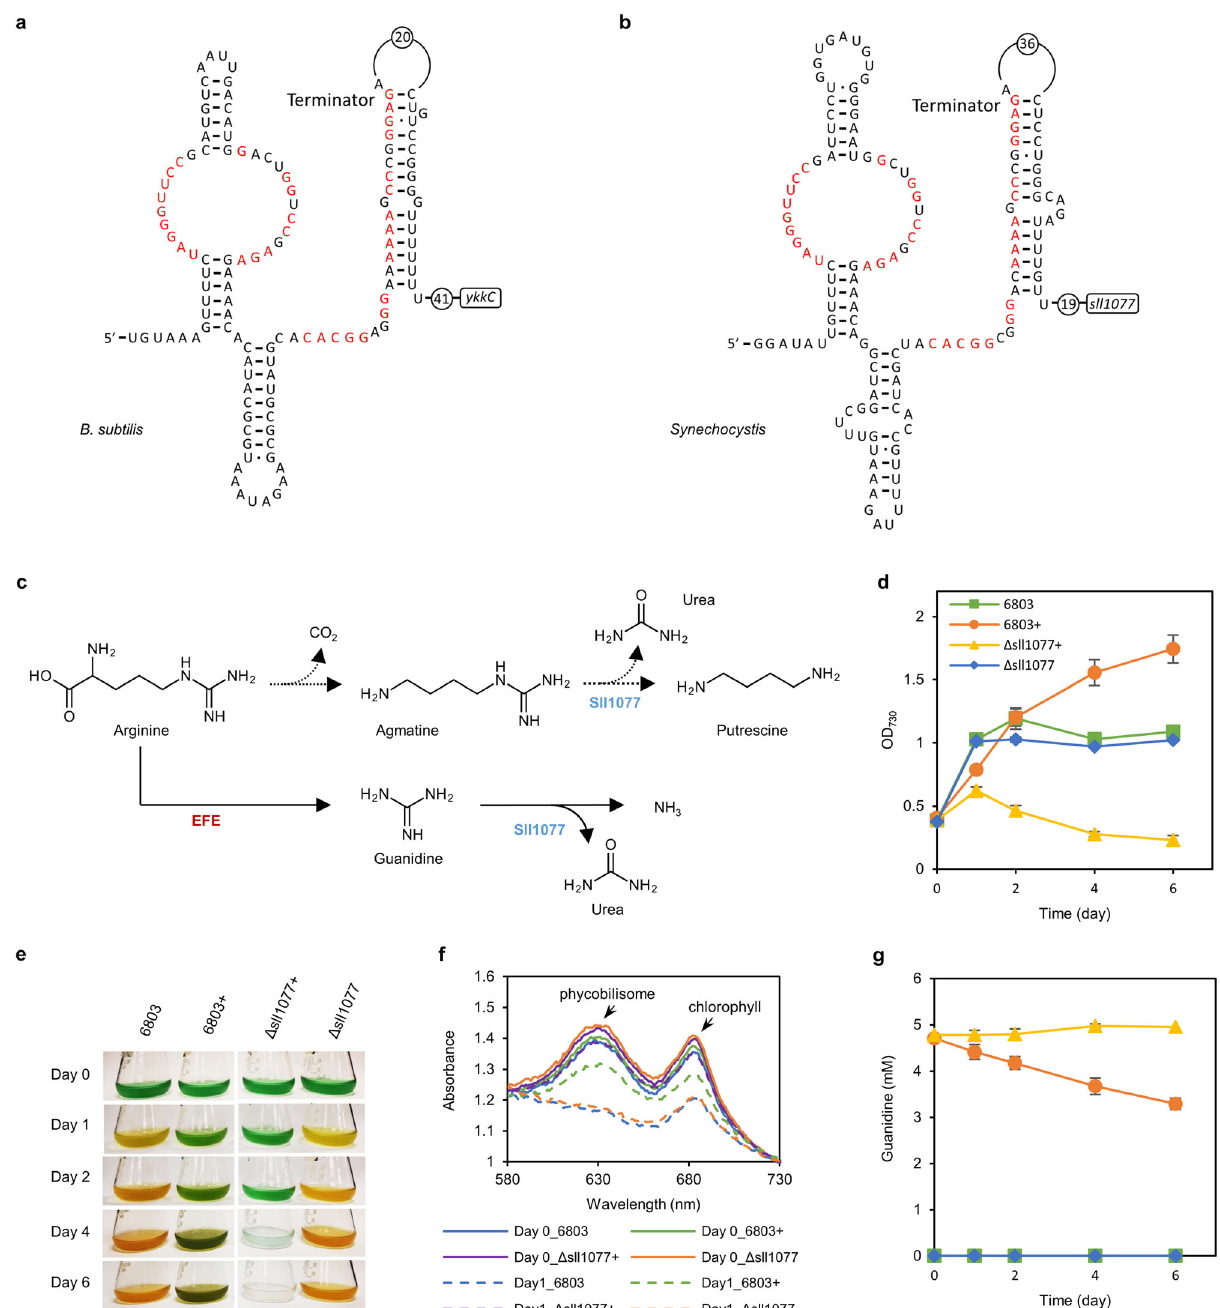
Fig. 2 Gene sll1077 is responsible for guanidine degradation in Synechocystis 6803. a The secondary RNA structure of the guanidine riboswitch upstream of the guanidine exporter encoded by the ykkC gene in Bacillus subtilis . Nucleotides in red are >97% conserved in type I guanidine riboswitch 5 . b The secondary RNA structure of predicted guanidine riboswitch upstream of the sll1077 gene in Synechocystis 6803. The consensus guanidine riboswitch nucleotides are depicted in red. c The proposed metabolic role of Sll1077 in degrading guanidine as depicted by solid arrows. Sll1077 was previously annotated as an agmatinase in one arginine degradation pathway as depicted by the dotted arrows 15 . d Time courses of cell densities of Synechocystis 6803 and the Δ sll1077 strain (PB805W) grown in nitrate-deprived medium with or without guanidine supplementation. In total, 5 mM guanidine was added into the nitrate-deprived medium as indicated by “ + ” following the strain names. e Phenotypes of Synechocystis 6803 and the Δ sll1077 strain (PB805W). f Absorbance spectra of cultures at day 0 and day 1 as shown in d . Absorbance was normalized to absorbance at 730 nm. g Time courses of guanidine concentrations in the culture supernatants. Data represent means and standard deviations from three biological replicates. Source data underlying panels ( d , g ) are provided as a Source Data fi Sll1077 prefers guanidine rather than agmatine as the sub- Synechococcus 7942 did not show any apparent impact on the cell strate . To examine the substrate preference of Sll1077 toward growth under either nitrate-deprived or nitrate-containing cul- ture conditions (Supplementary Fig. 7), suggesting that Syne- guanidine and agmatine, the crude cell extract of Synechococcus chococcus 7942 is highly tolerant to urea. 7942 and GD7942 was incubated with 5 mM of either guanidine